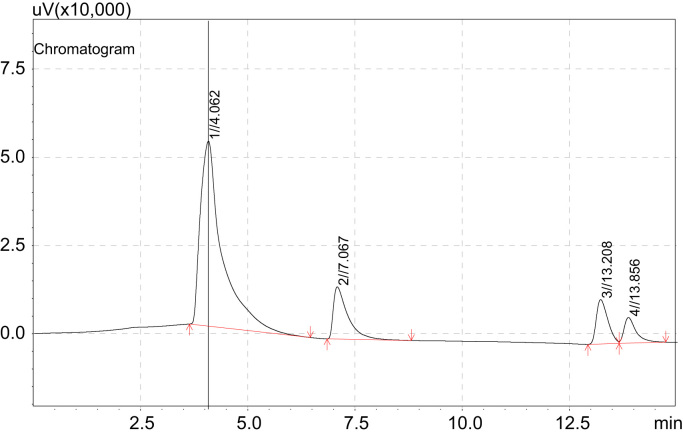
Sample standard.